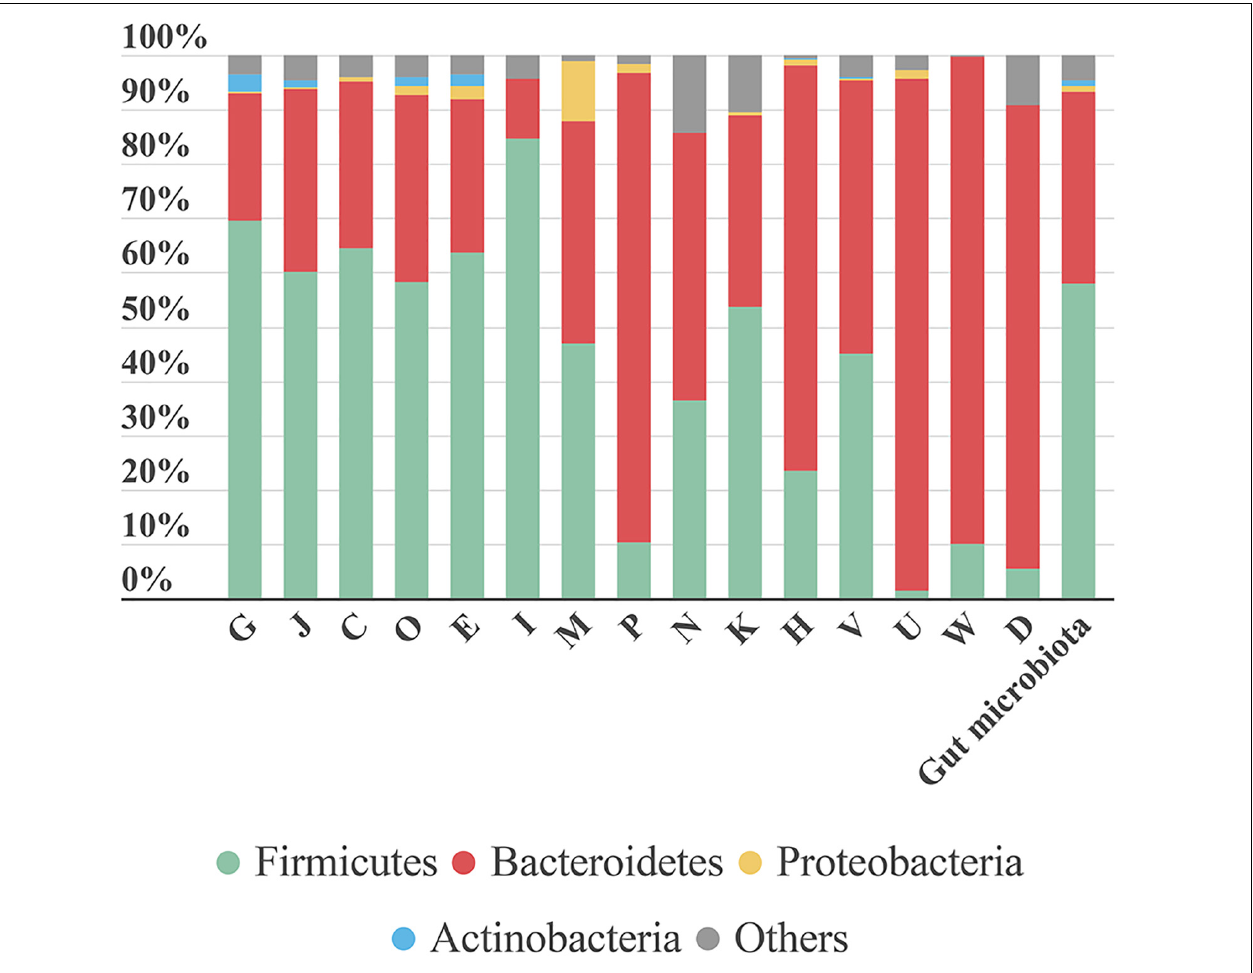
FIGURE 7 | Bar plot representing the contribution of each phylum to the COG category analyzed. The last bar represents the taxonomic distribution of these phyla in the gut microbiota samples. Each phylum’s contribution in each sample is calculated as the sum intensity of proteins of this phylum annotated to the COG category. This bar plot represents the mean abundance of the six samples. G, Carbohydrate transport and metabolism; J, translation, ribosomal structure and biogenesis; C, energy production and conversion; O, post-translational modification, protein turnover, chaperones; E, amino acid transport and metabolism; I, lipid transport and metabolism; M, cell wall/membrane/envelope biogenesis; P, inorganic ion transport and metabolism; N, cell motility; K, transcription; H, coenzyme transport and metabolism; V, defense mechanisms; U, intracellular trafficking, secretion, and vesicular transport; W, extracellular structures; D, cell cycle control, cell division, chromosome